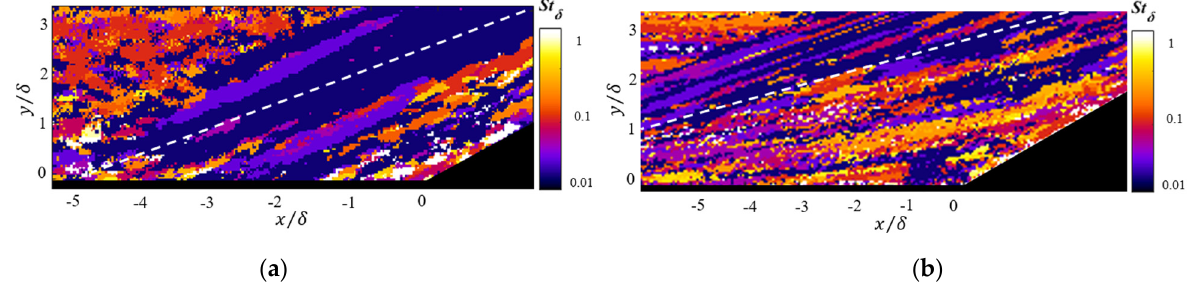
Figure 10. Plots of Strouhal number in the interactions region for representative ( a ) smooth and ( b ) rough interactions. The white dashed lines indicate the mean shock positions for each case.